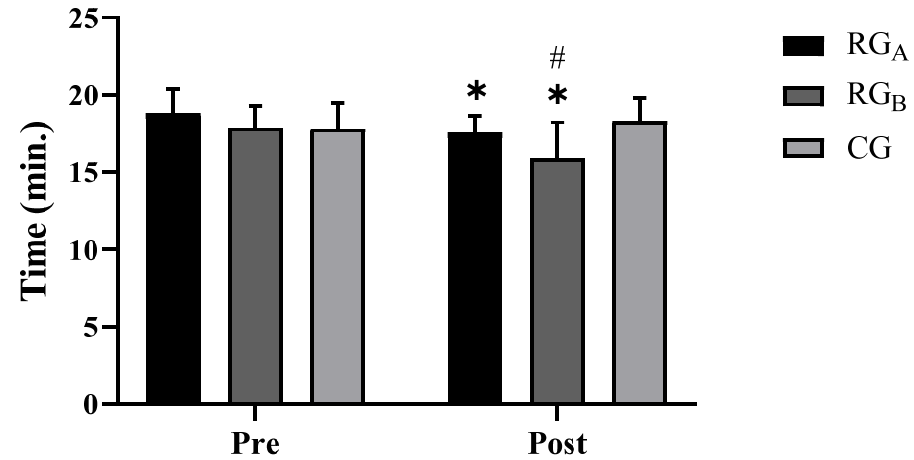
Figure 5. Walking performance for groups, before and after the interventions. * Significant difference compared to the pre-intervention moment for the same group ( p < 0.05). # Significant difference compared to the strength and Control Group after the intervention ( p < 0.05).